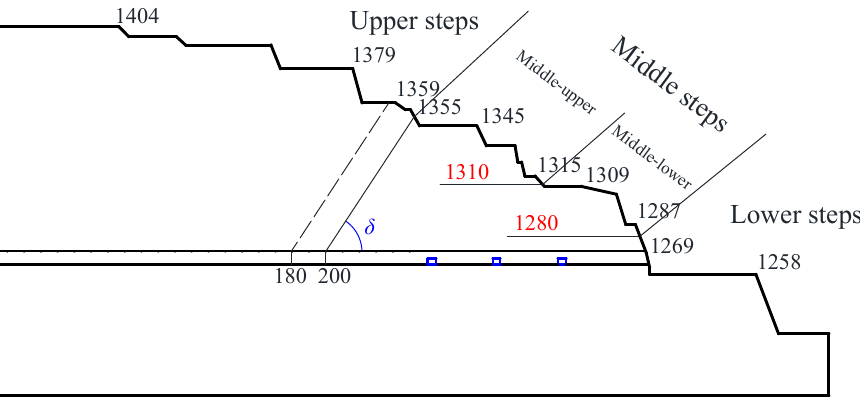
Figure 8. Step classification in a disturbed slope.